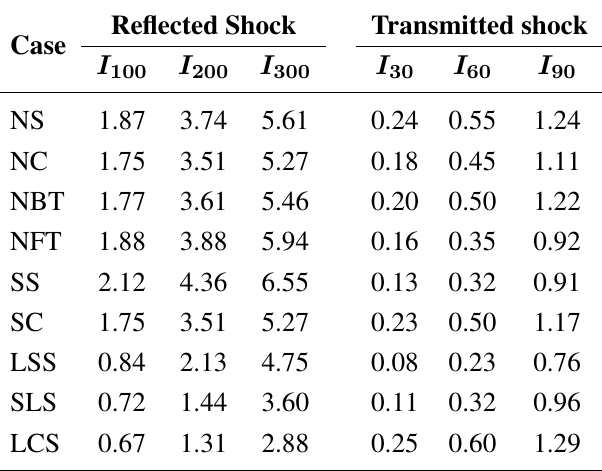
Table 3. Impulse, I , recorded by the upstream (reflected shock) and downstream (transmitted shock) probes for three time intervals. Units in Pa ·